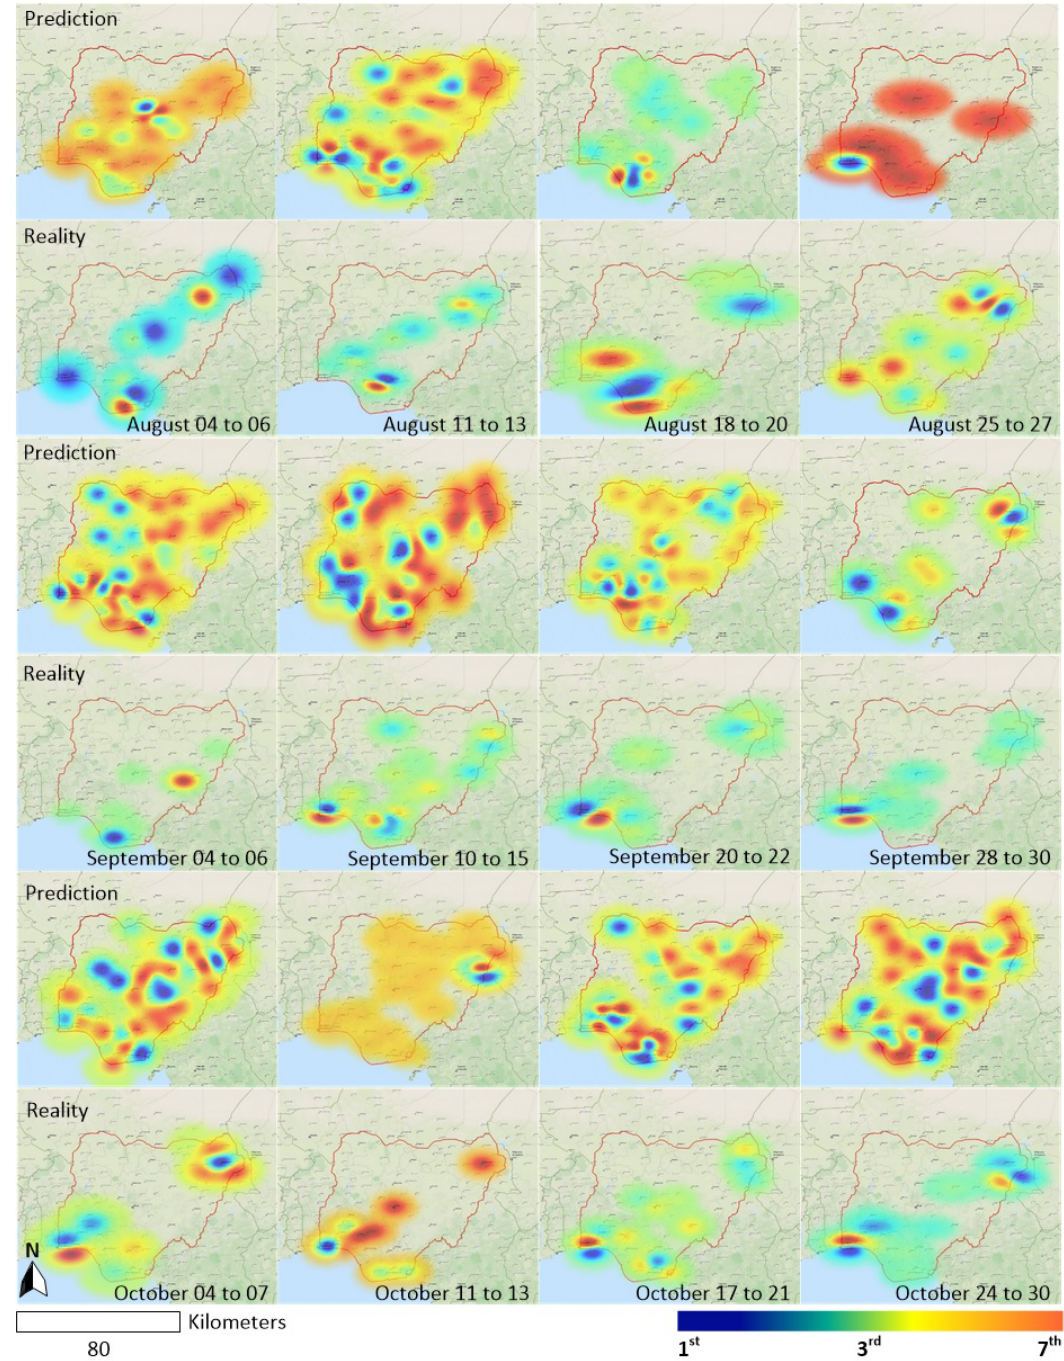
Figure 9. A comparison of spatiotemporal evolving of conflicts from August to